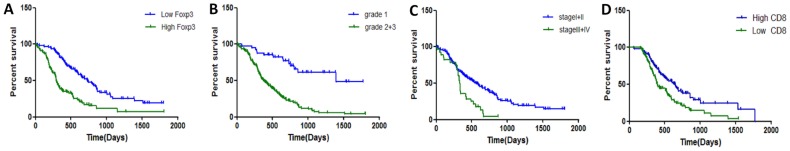
Survival curves for univariate analyses.(A) The survival rates of PDA patients with a high or low proportion of intratumoral Foxp3+ cells were estimated by the Kaplan-Meier method. The log-rank test was applied to compare the two groups. (B) Survival rates for patients with different tumor histological grades were estimated by the Kaplan-Meier method. (C) Survival rates for patients with the indicated TNM stages were estimated by the Kaplan-Meier method. (D) Survival rates for patients with a high or low proportion of intratumoral CD8+ cells were estimated by the Kaplan-Meier method.